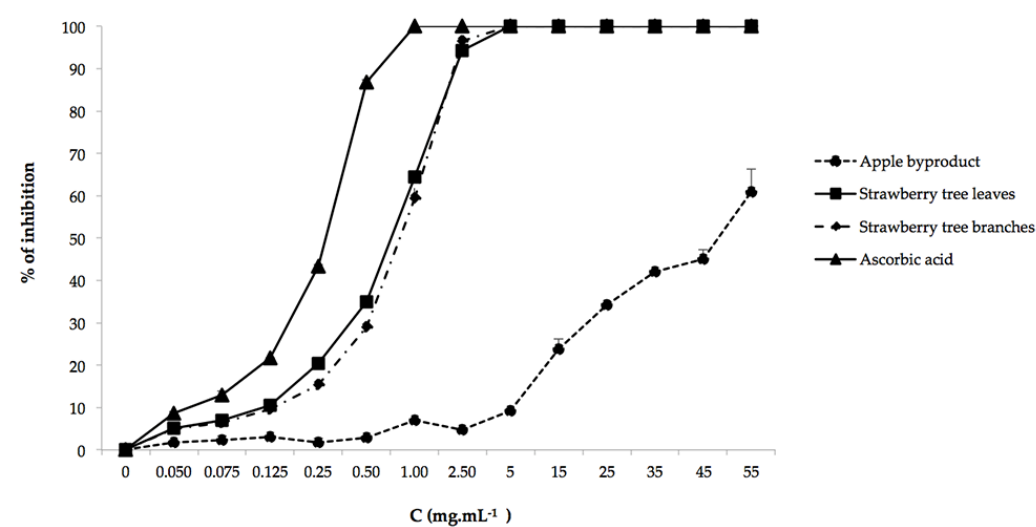
Figure 1. Values of ABTS + radical inhibition (%) by NES. Ascorbic acid was used as positive control. Data are mean ± standard deviation (SD) (n = 3).